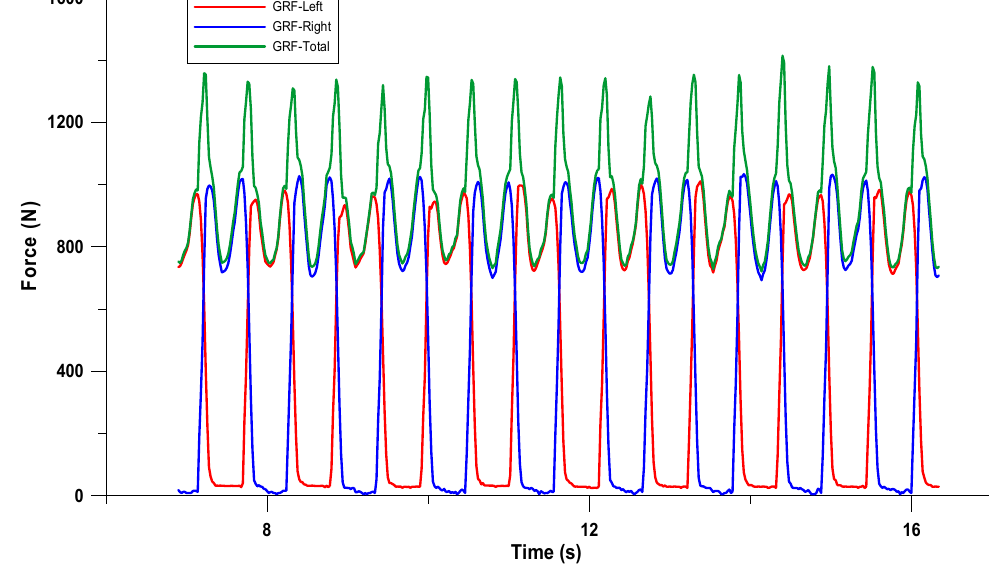
Figure 1. Forces of both left and right foot with respect to time during medium speed walking, together with the summed forces of both feet (GRF = Ground Reaction